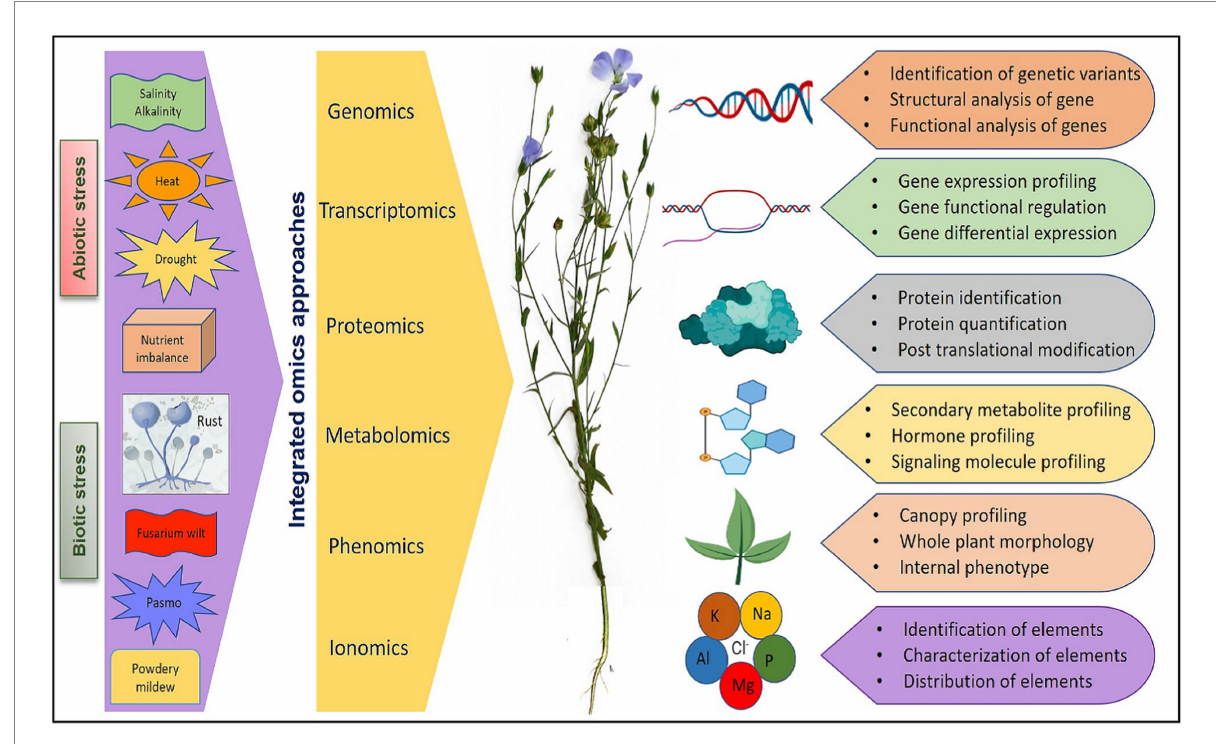
FIGURE 2 An overview of integration of different omics approaches for flax improvement under various abiotic and biotic stresses.